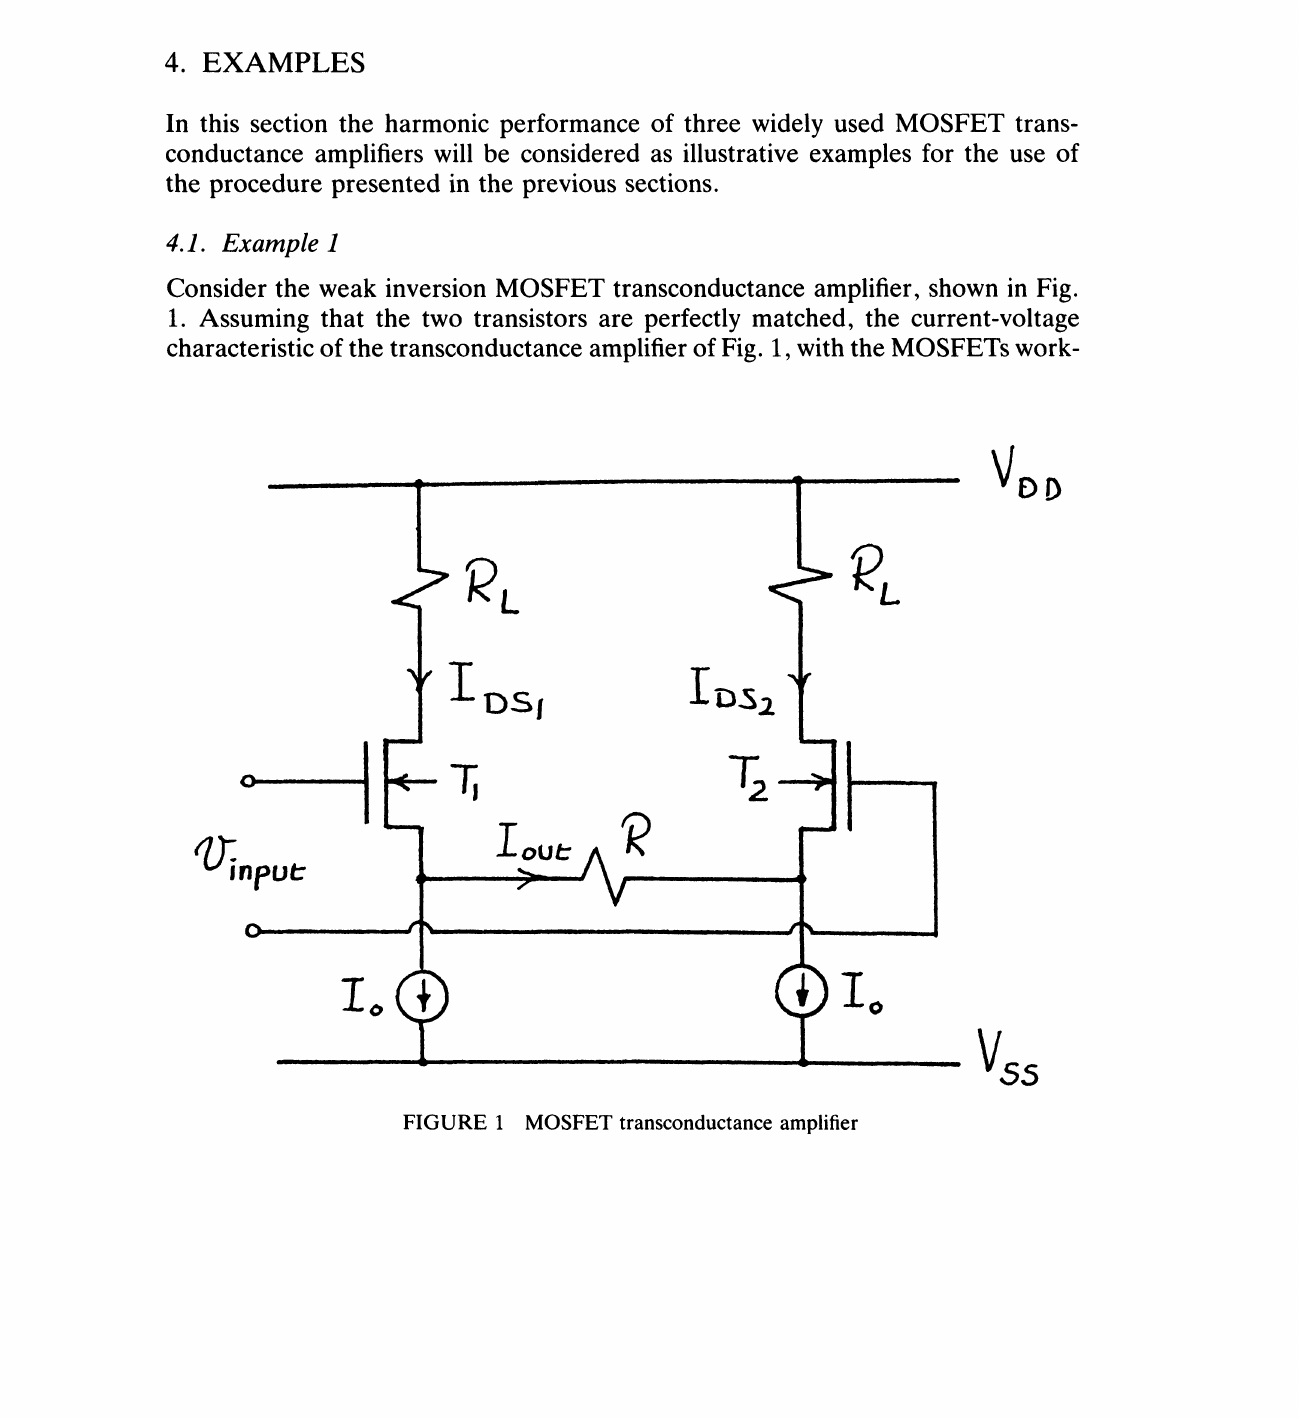
FIGURE MOSFET transconductance